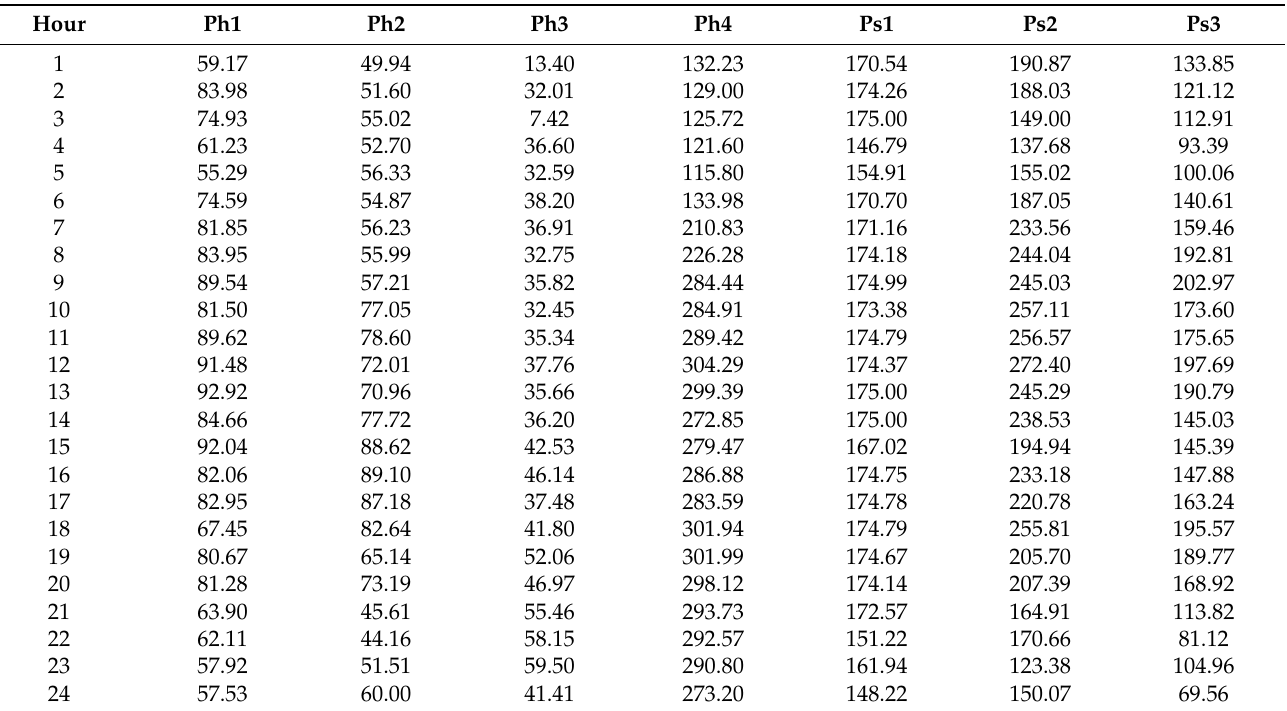
Table 12. Table of output process of hydropower and thermal power units (unit: